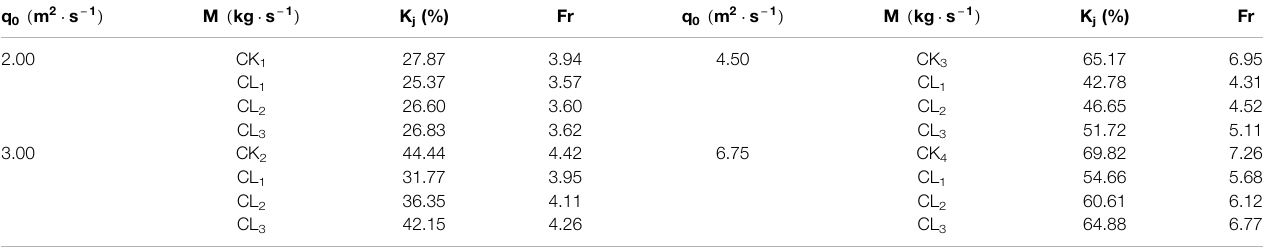
TABLE 3 | Stilling basin energy dissipation rate and Fr under different treatments.